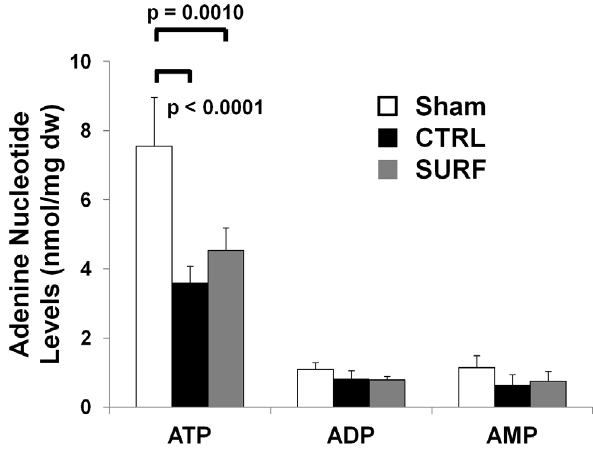
Figure 2. Adenine nucleotide levels. ATP, adenosine triphosphate; ADP, adenosine diphosphate; AMP, adenosine monophosphate; dw, dry weight. Data are shown as mean 6 SD.